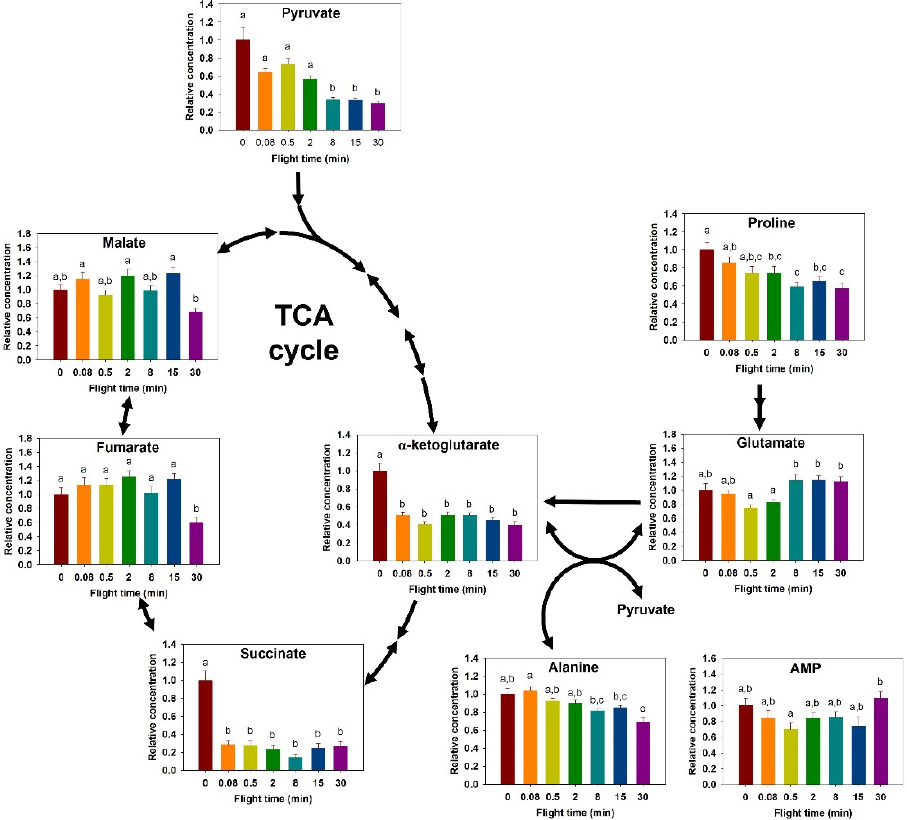
Figure 2. Relative change in tricarboxylic acid cycle (TCA) metabolism intermediates during the progression of a 30-min flight in the thorax of the bumblebee Bombus impatiens . Colors correspond to flight times (red = 0 min, orange = 5 s, yellow = 30 s, green = 2 min, light blue = 8 min, dark blue = 15 min, purple = 30 min). Columns that do not share a letter are significantly different ( p < 0.05).